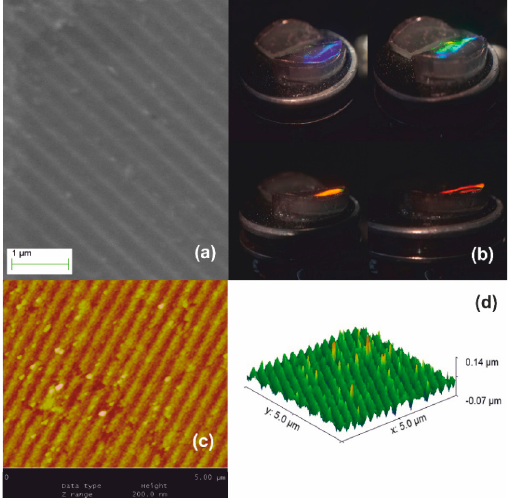
Figure 6. Xerogel Stage III systolic processing yields further 1.2× size reduction: ( a ) SEM image of the downsized replica having period Λ xero-III ~280–300 nm; ( b ) white light diffraction produces structural colors observable by internal incidence at very oblique angles; ( c ) AFM image; and ( d ) AFM surface relief presentation.